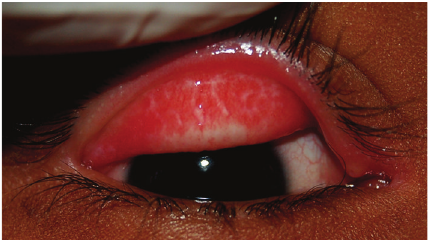
Figure 8: Trachomatous scarring (TS stage). Figure courtesy of Hollman Miller, Vaup´es, Colombia.